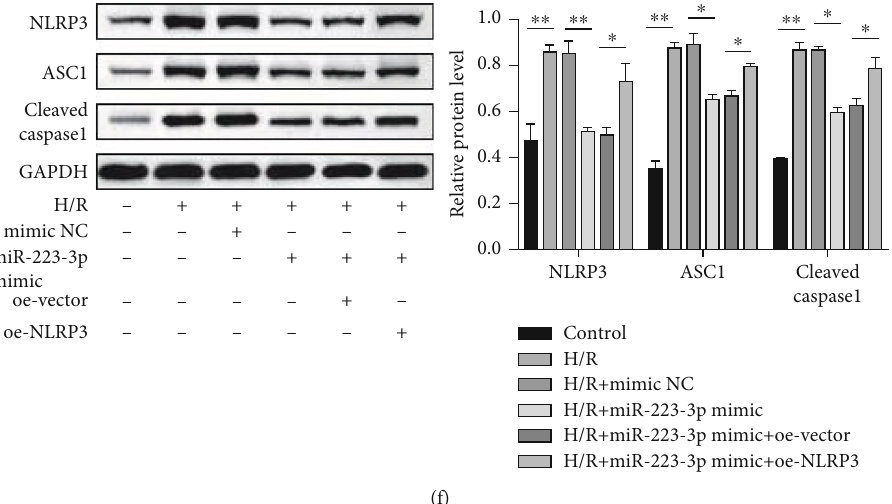
Figure 7: miR-223-3p suppressed apoptosis and in fl ammasome activation and promoted mitophagy in H/R-induced TCMK-1 cells by targeting NLRP3. TCMK-1 cells were subjected to H/R stimulation and miR-223-3p-depleted exosome treatment. (a) H/R-induced cell apoptosis was determined through fl ow cytometry. (b) The protein levels of BAX, cleaved caspase-3, and Bcl-2 were con fi rmed by performing the western blot analysis. (c) Expressions of the mitophagy markers were detected using western blot analysis. (d) Mitophagosome formation was assessed based on the colocalization of the autophagy marker GFP-LC3B and the mitochondria marker Mito Tracker (DsRed-Mito). (e) The levels of mitochondrial DNA (mtDNA) were determined through qPCR. (f) The expressions of NLRP3, ASC1, and cleaved caspase 1 were determined using the western blot analysis. N = 3 . ∗ P < 0 : 05 ; ∗∗ P < 0 : 01 ; ∗∗∗ P < 0 : 001